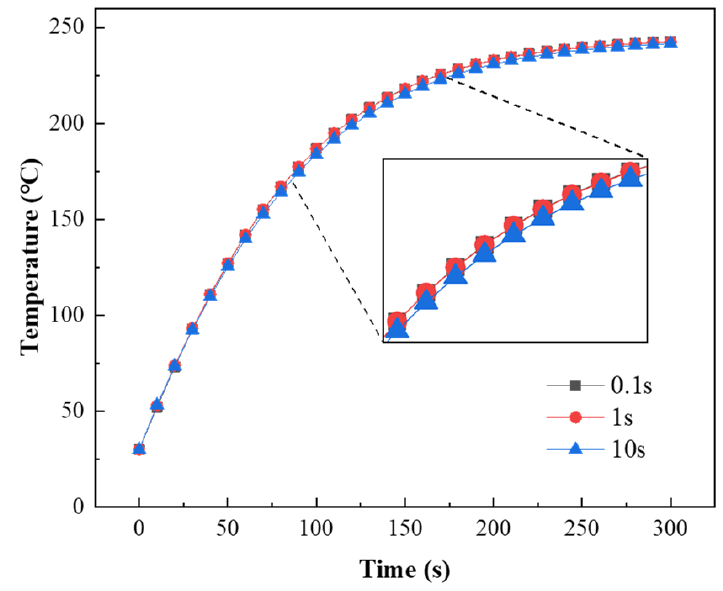
Figure 18. Coating temperature versus time with different time steps.